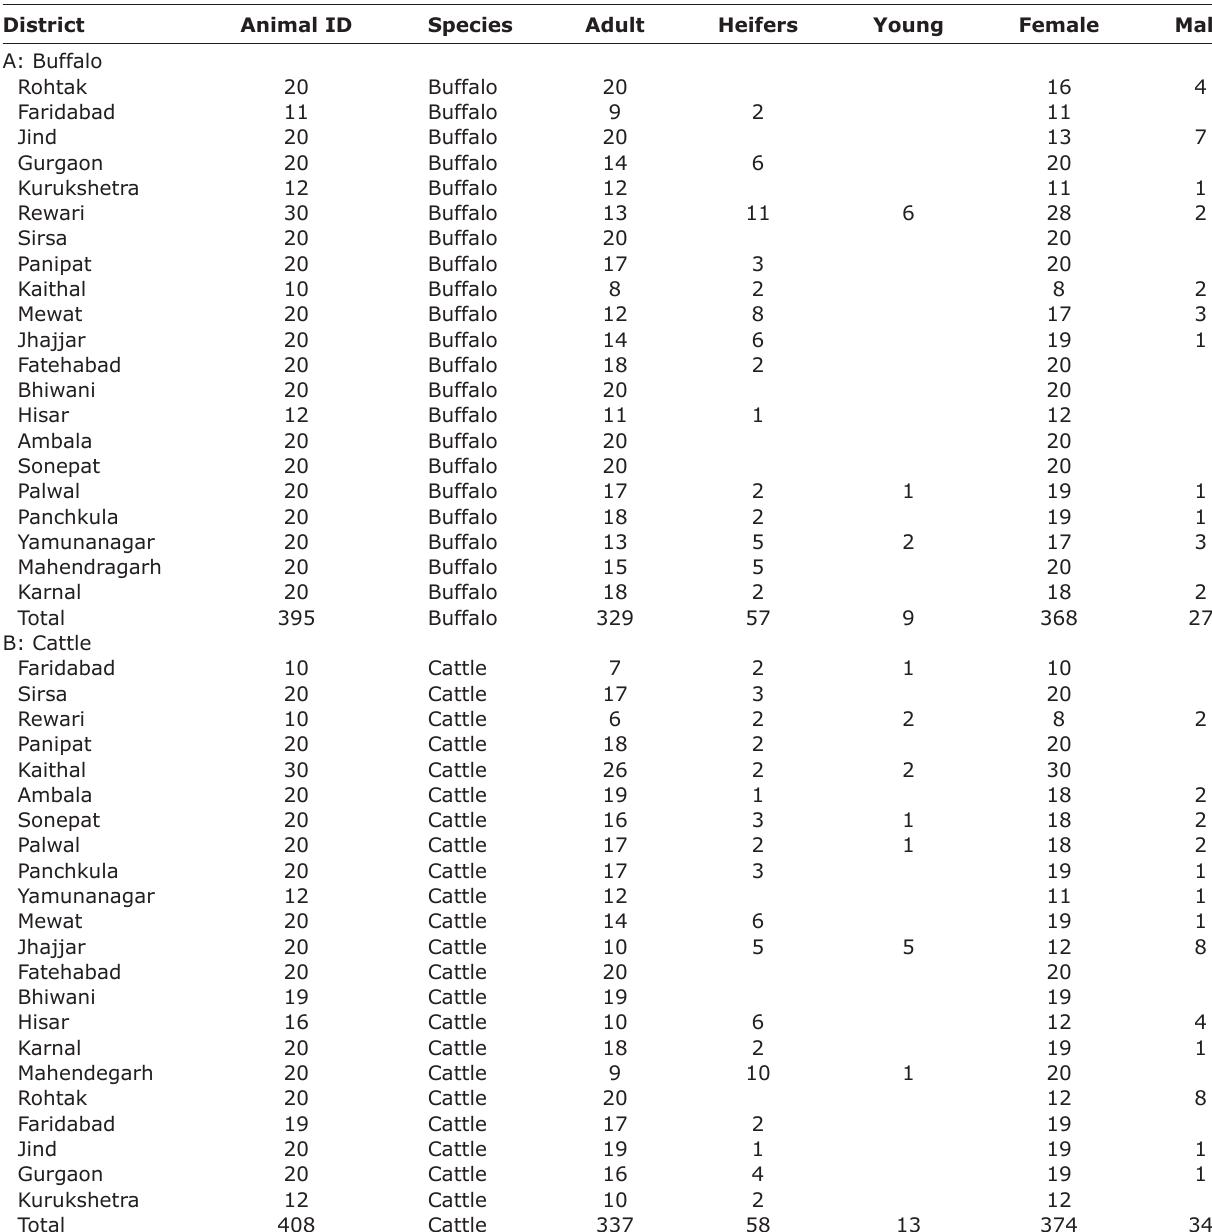
Table-1: Details of animals from which samples were collected. District Animal